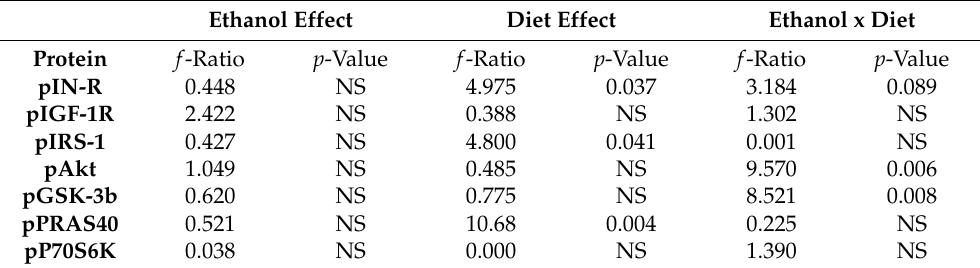
Table 4. Ethanol and Dietary Protein Effects on Phospho-Akt-Pathway Proteins.